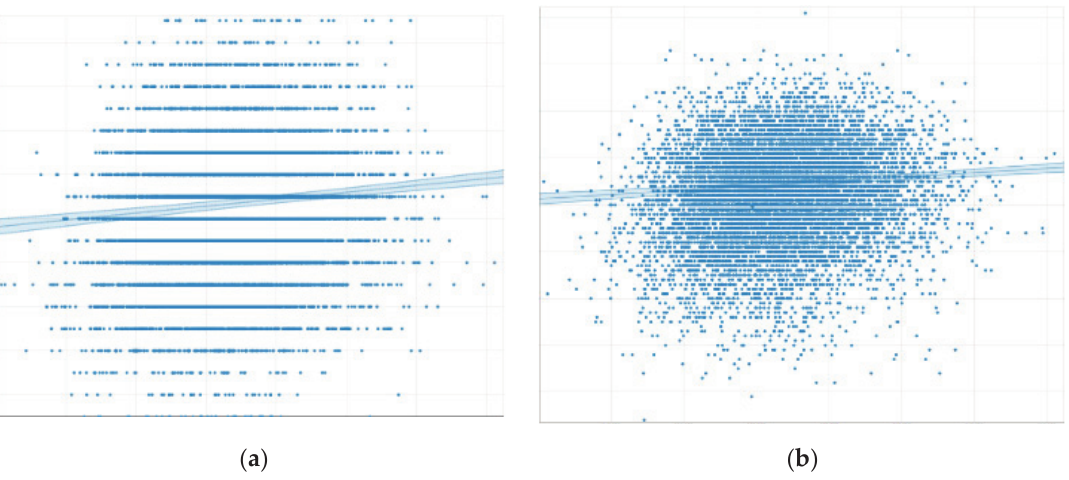
Figure A1. Correlation between whole-brain cortex surface area (our outcome) and our cognitive validation measures. ( a ) Correlation between whole-brain cortex surface area (our outcome) and Wisconsin Cognitive ability (TSS); ( b ) Correlation between whole-brain cortex surface area (our outcome) and National Institutes of Health (NIH) Toolbox Fluid Cognitive